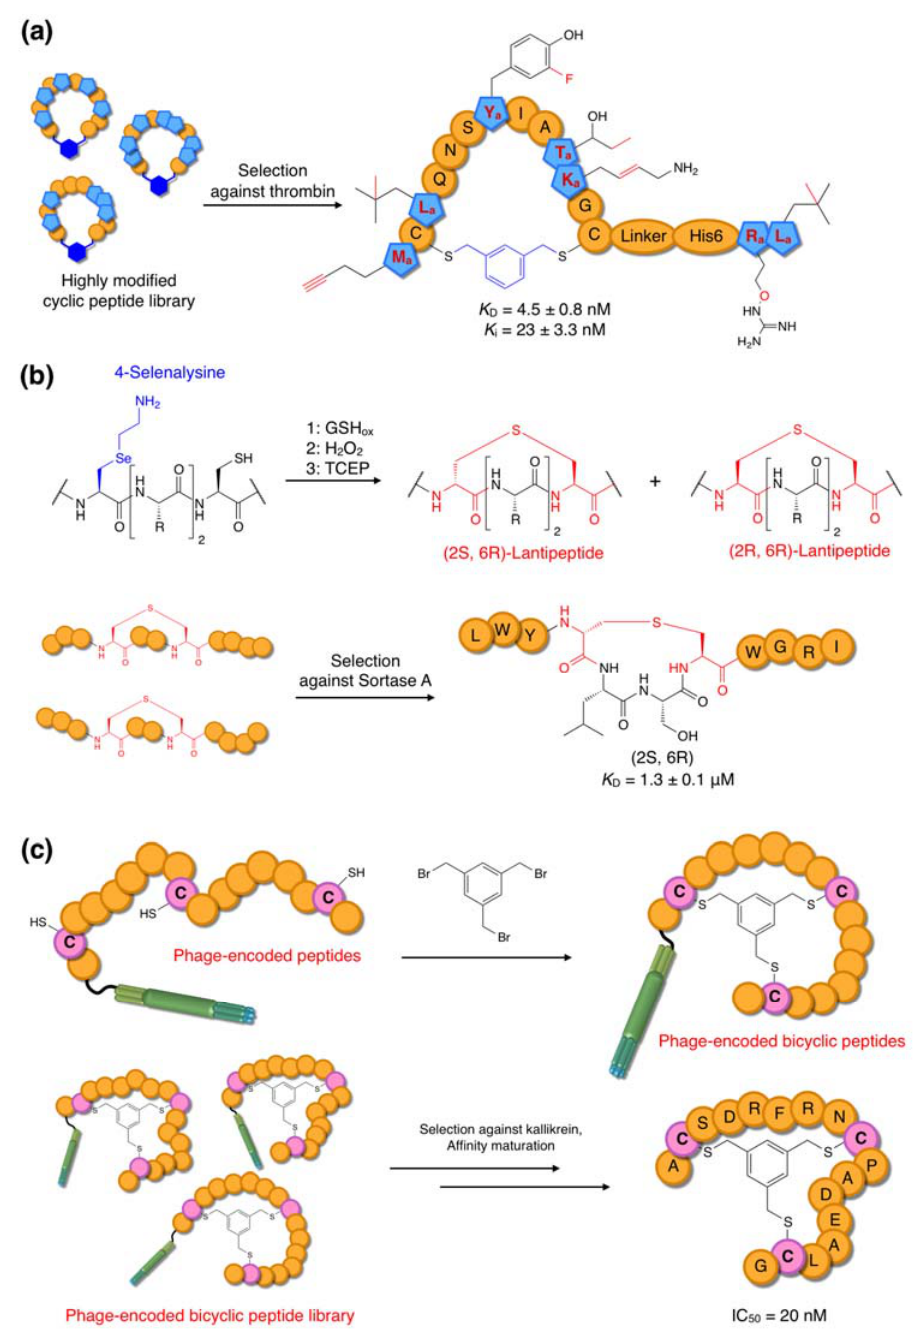
Figure 9. Other selection platforms. ( a ) Anti-thrombin cyclic peptides [70]. A library containing non-standard cyclic peptides containing up to 12 non-canonical amino acids was used for the selection of thrombin inhibitors. Macrocycles were formed by the reaction of two Cys residues with a bifunctional dibromoxylene linker. A selected active peptide contains six different non-canonical amino acids. ( b ) Anti-sortase A lantipeptide-like peptides [75]. An incorporated 4-selenalysine underwent elimination to dihydroalanine by H O oxidation, and the lanthionine moiety was then formed by 1,4-addition of a Cys 2 2 sulfhydryl group with dihydroalanine. ( c ) Anti-kallikrein “bicycle” peptides [76]. A library of peptides containing three spaced Cys residues was displayed on phage, and its treatment with TBMB yielded bicyclic peptides with six random amino acids in each